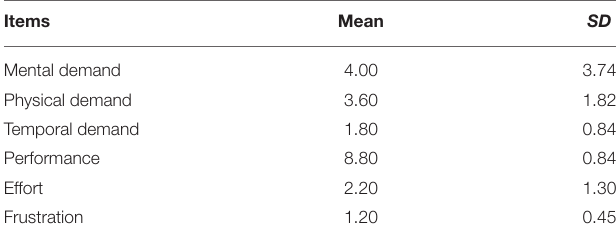
TABLE 8 | Cognitive load evaluation based on